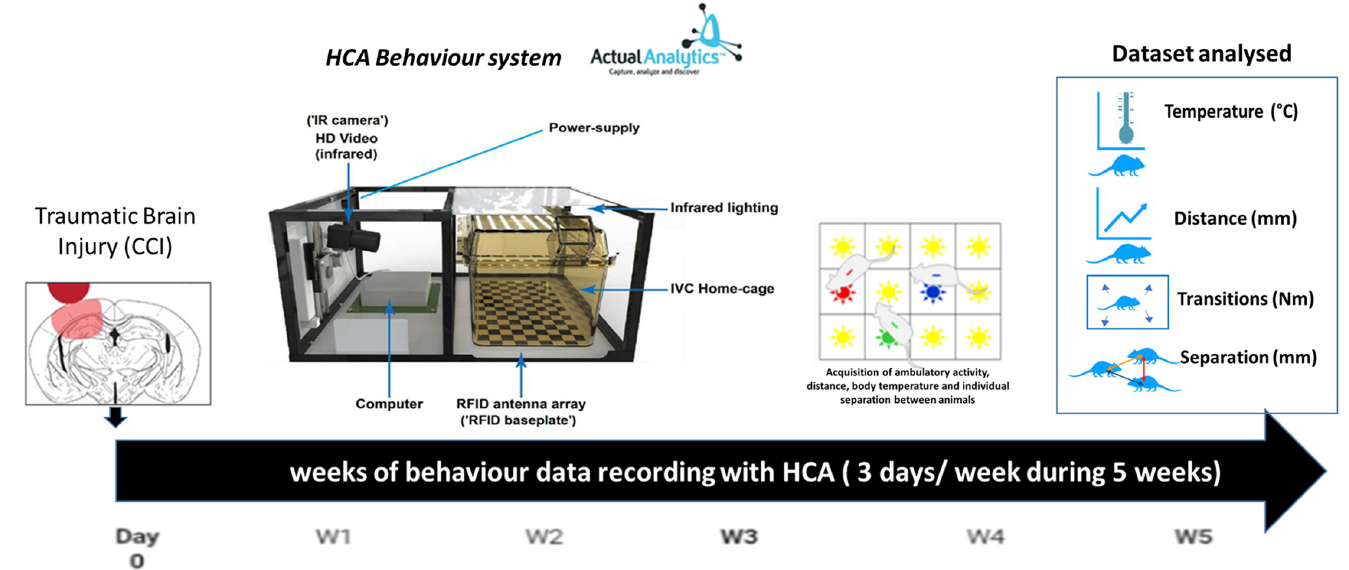
Fig 1. Representative scheme of the experimental behaviour data acquired for the study. Briefly, animals were subjected to a controlled cortical injury via a craniotomy to expose the cortical brain (CCI- TBI injured group) , a craniotomy alone without cortical injury (Sham craniotomy group) , all under aseptic surgery and anaesthesia with analgesic support. All animals were implanted with a RFID chip. Naive animals were implanted with RFID under a brief anaesthesia, with no other interventions. Animals were grouped housed in their home cages, which were placed on top of the baseplate RFID reader and exposed to a side video camera from the Home Cage Analyser (ActualHCA ™ ) system. Non-disturbance recordings were set up as 15 min timeframes and throughout 3 days periods per week, during 5 weeks post-intervention. Naive data was recorded only for a single week as a baseline data. Automated data acquired via the HCA systems included body temperature per individual animal ( º C), distance travelled per individual animal (mm), number of transitions between RFID set up detectors (Nm) and average separation between animals (mm). This time-series raw data was then pre-processed and utilised to train our machine learning models.